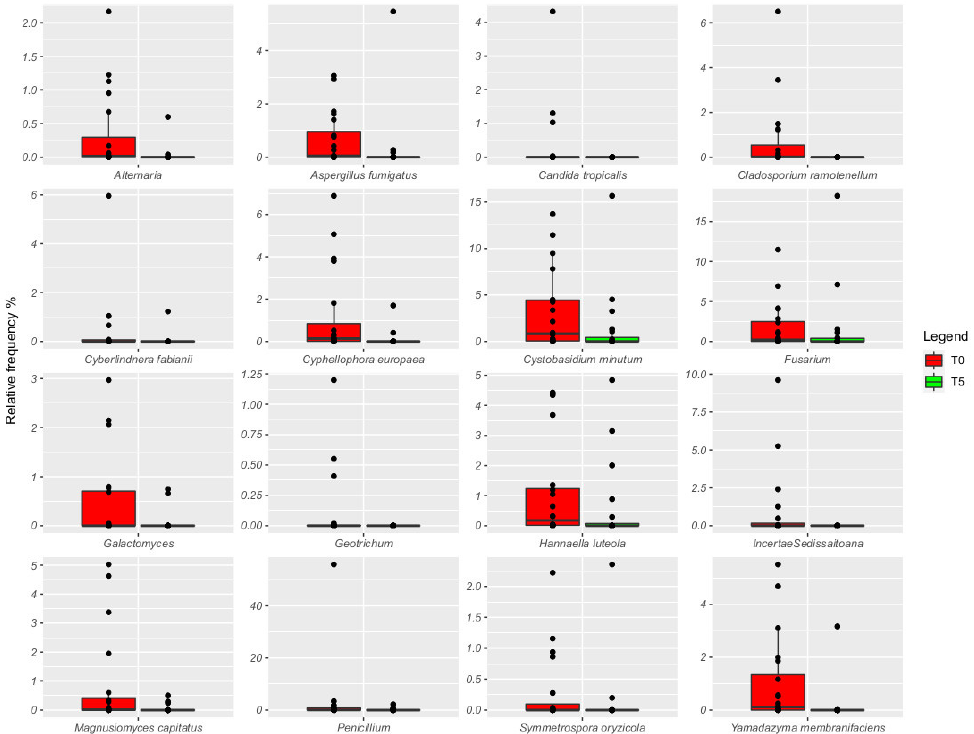
Figure 4. Relative frequency of differentially abundant fungal ASVs in fecal samples of dogs during the experimental trial. Pairwise Kruskal–Wallis test, FDR < 0.05.